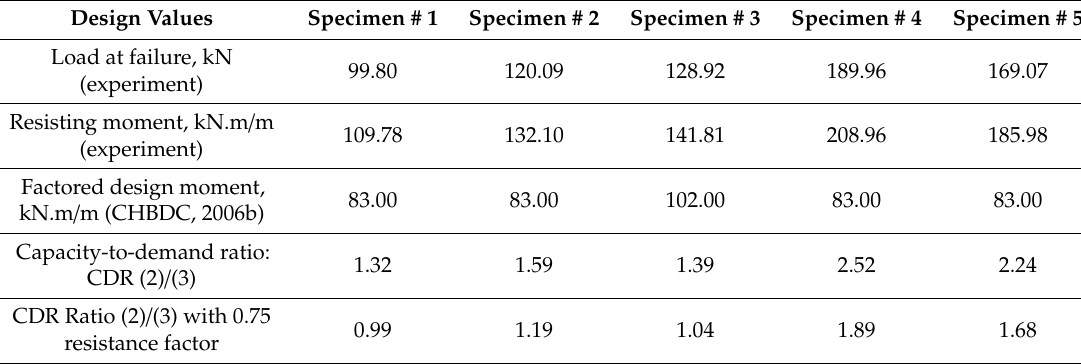
Table 2. Experimental results.